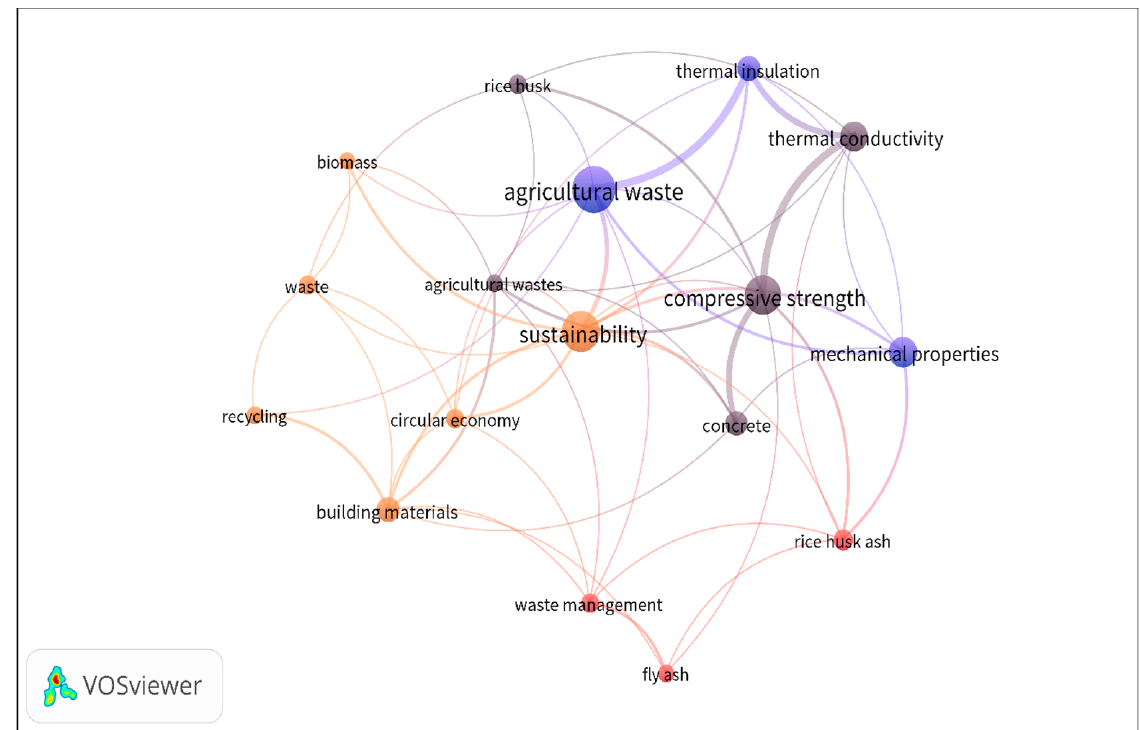
Table 2. Quantitative summary of influence of